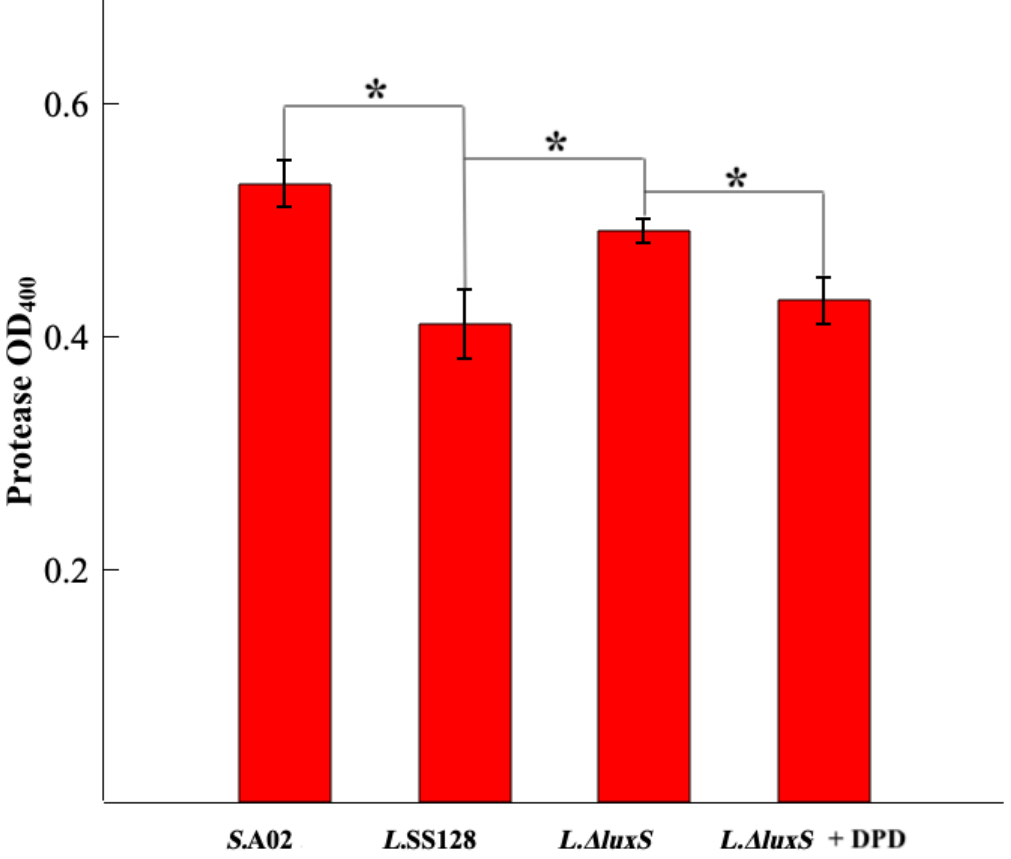
Figure 3. Protease content after culture for 80 h at 4 °C. * Represents mean values differ signifi- cantly at p < 0.05. at p <